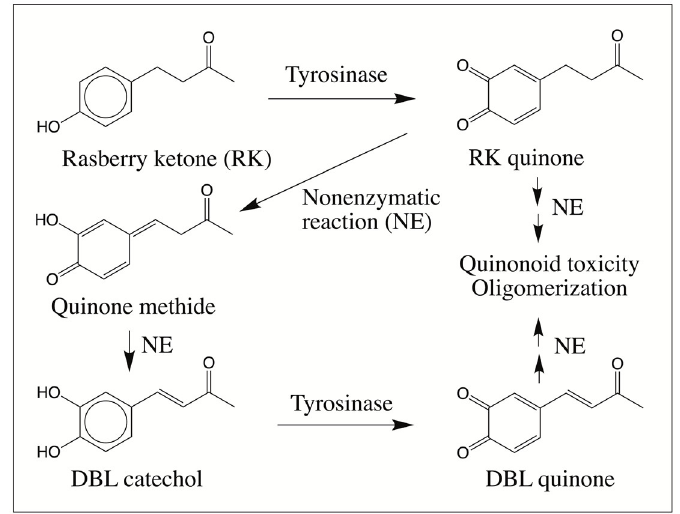
Figure 1. Proposed fate of raspberry ketone (RK). Tyrosinase performs facile oxidation of RK to RK quinone. This quinone causes depletion of thiols and exhibits cellular toxicity. In addition, it also undergoes nonenzymatic isomerization to DBL catechol through the intermediate formation of isomeric quinone methide. DBL catechol is further oxidized to its quinone either by tyrosinase or nonenzymatically by RK quinone. The DBL quinone thus formed is more reactive than the saturated RK quinone and hence it too exhibits cellular toxicity. It also seems to undergo polymerization to more toxic compounds (NE = nonenzymatic reaction).